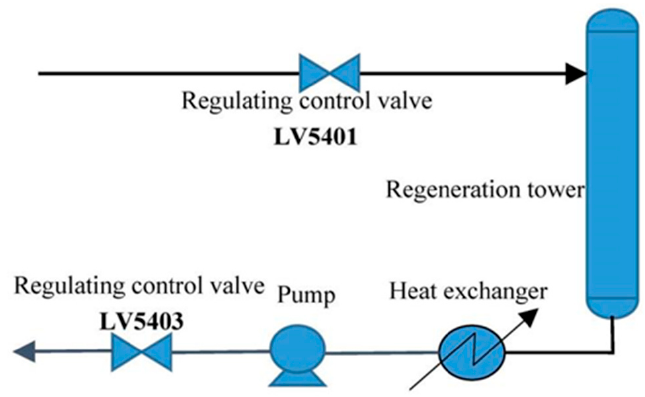
Figure 1. Schematic diagram of the process fl ow of the failed regulating